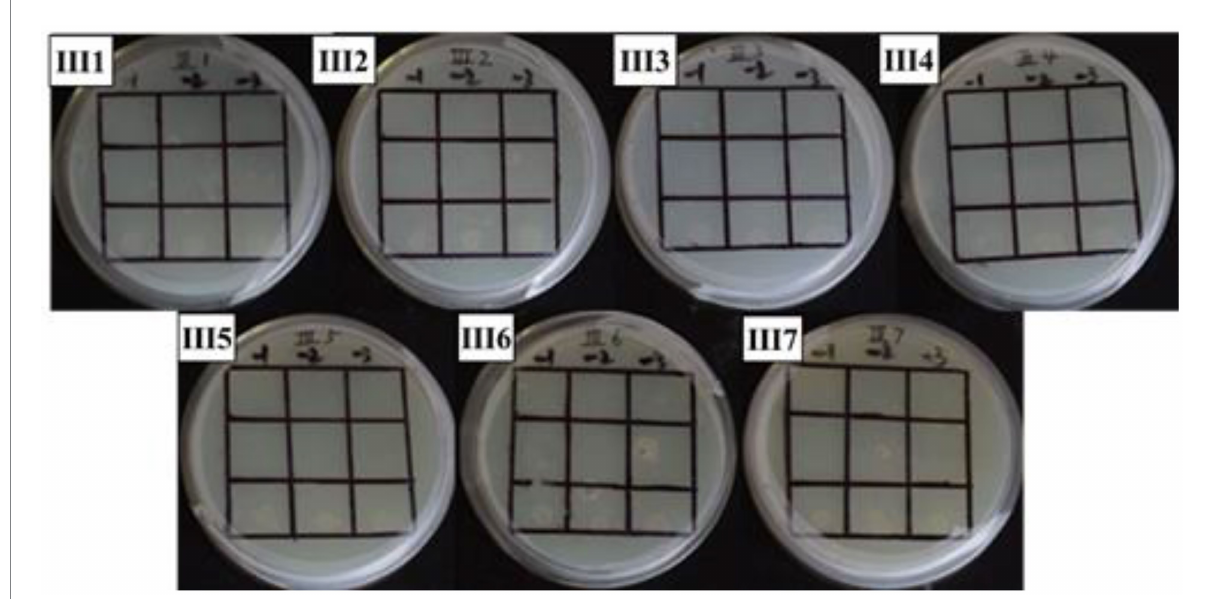
FIGURE 7 Positive sieve plate with 2 mM 3’AT, 0 μ g/ml NaNO 2 (III1), 20 μ g/ml NaNO 2 (III2), 40 μ g/ml NaNO 2 (III3), 60 μ g/ml NaNO 2 (III4), 80 μ g/ml NaNO 2 (III5), 100